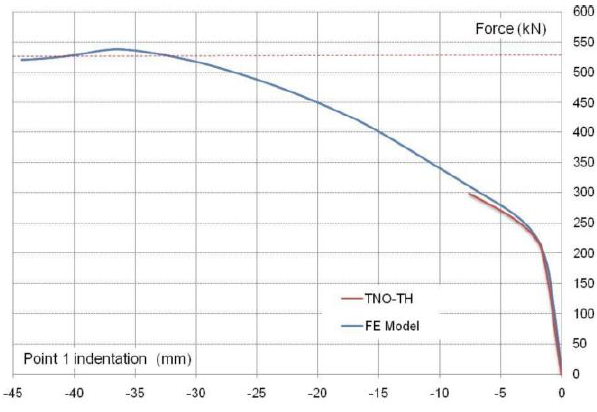
Figure 6. Curve compression force vs . indentation at point 1.